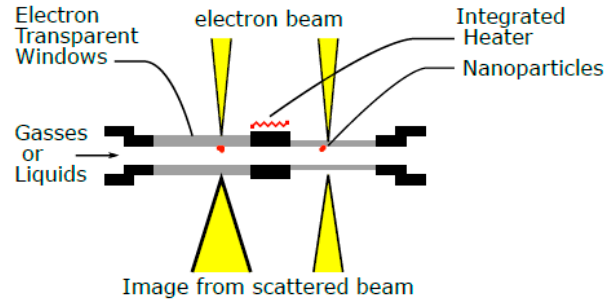
Figure 1. Schematic view of a MEMS nanoreactor and components. Two different ETWs are illustrated here. The thicker ETW (left) scatters the electron beam more strongly, which causes a reduction of resolution compared to the thinner window on the